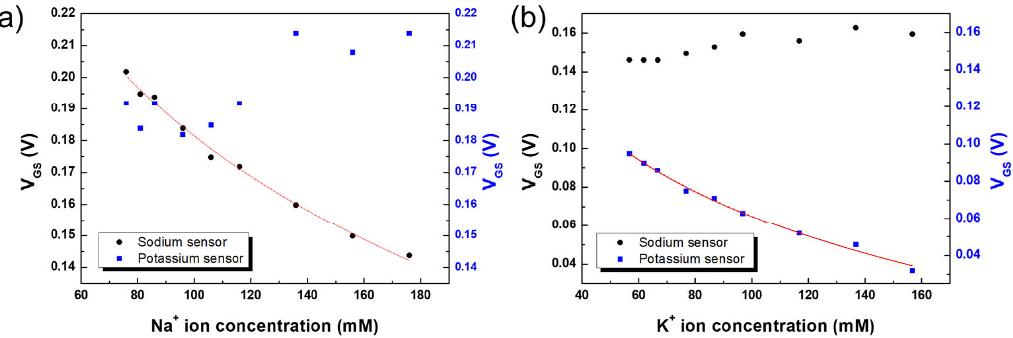
Figure 6. Detection of ( a ) Na + , ( b ) K + ions, and the sensitivities of ITO − ISFET − ISM with F − rGO RE sensors in patient urine samples.